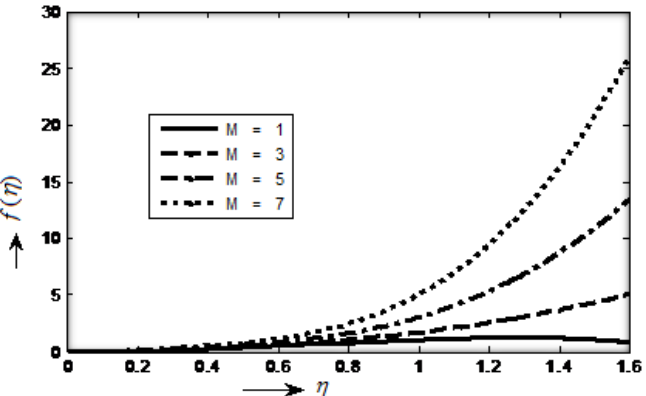
Figure 1. The graph of fluid velocity f (  ) against  for magnetic parameters ( M = 1.0, 3.0, 5.0, 7.0) by taking parameters K = 0.8, Re = 2.0 and 